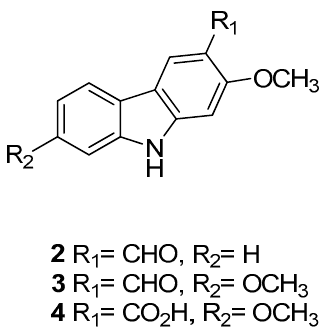
Figure 2. Structures of O -methylmukonal ( 2 ), 3-formyl-2,7-dimethoxycarbazole ( 3 ) and clauszoline J ( 4 ).